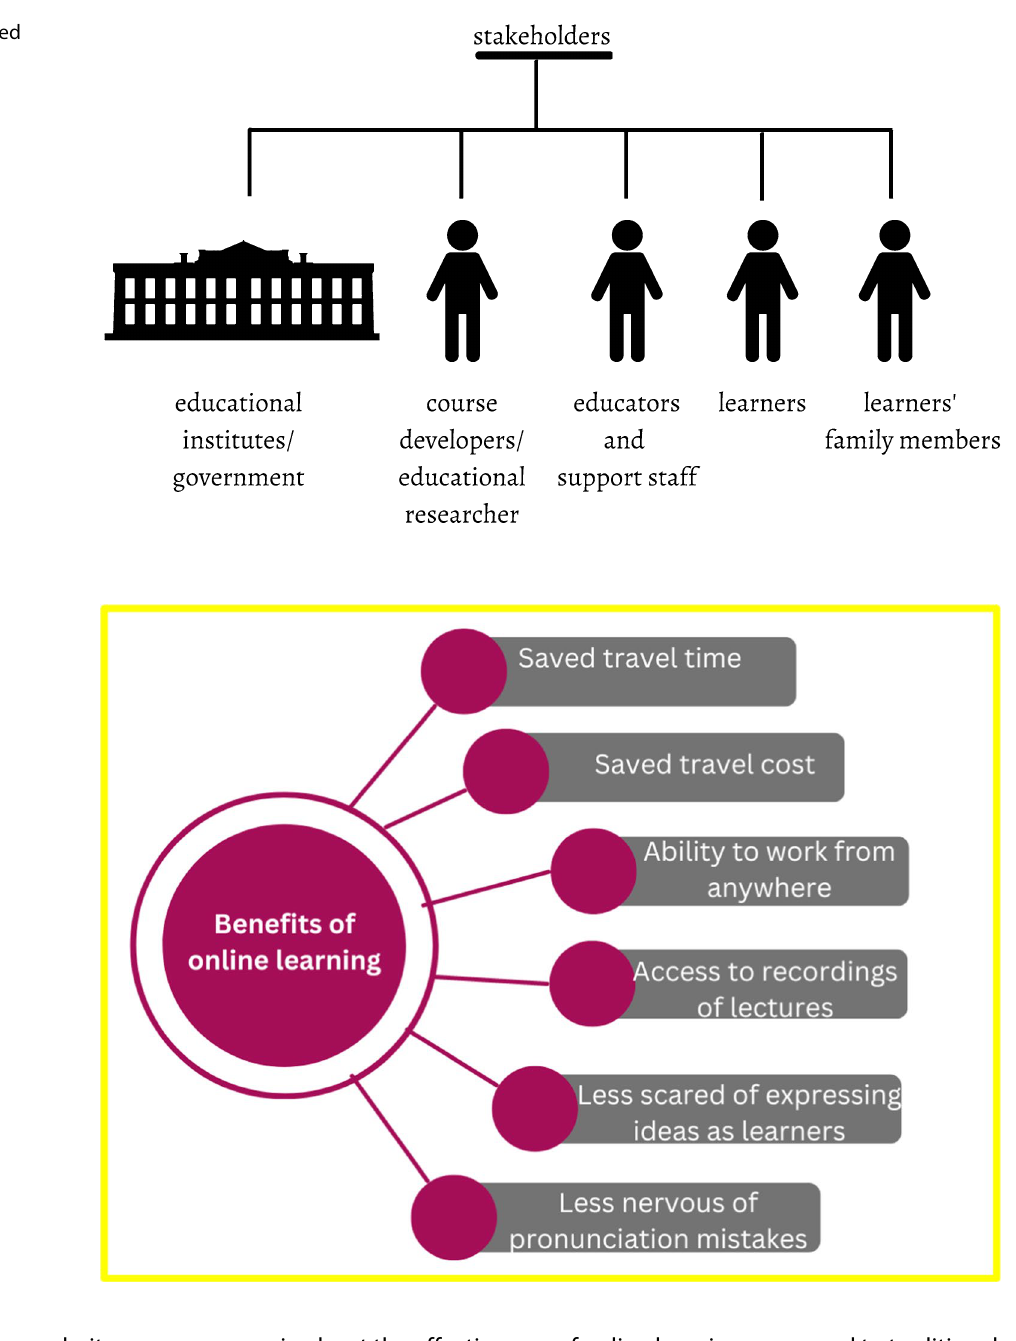
Fig. 2 Stakeholders involved in the learning process (Romero & Ventura, 2010) respectively